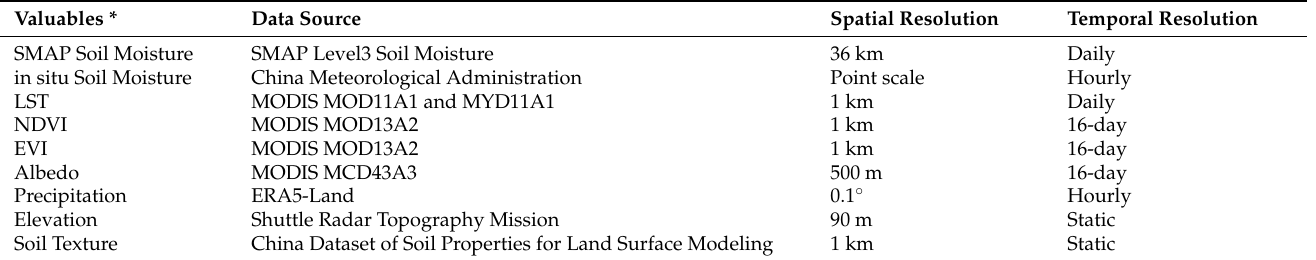
Table 1. Data sets used in the downscaling